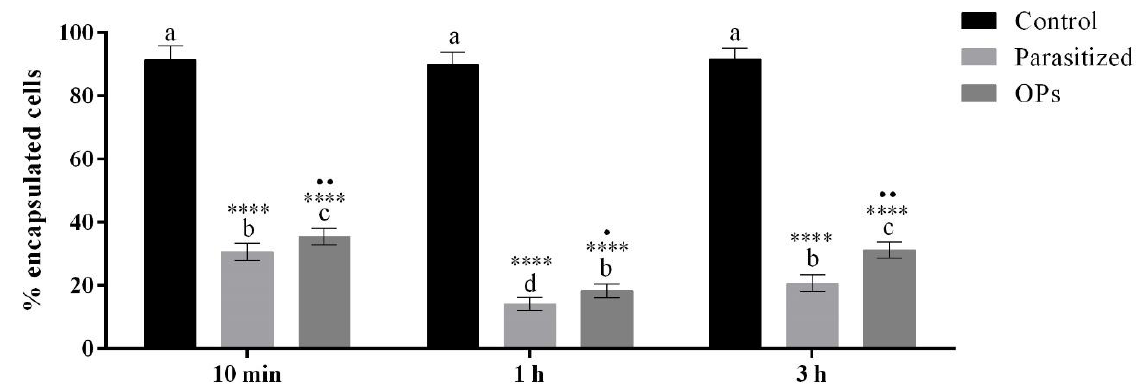
Figure 8. Percentage of encapsulation of chromatographic spheres extracted after 6 h from larvae injected with 1 × PBS (control), after parasitization or OP treatment at 10 min, 1 h or 3 h before injection of spheres. Data are presented as mean ± SD ( n = 3). Statistical analysis was performed with one-way ANOVA and Bonferroni (for control vs. treatment and parasitized vs. OPs analysis) and Tukey post-hoc test (for all sample analysis). Different letters indicate significant differences among all treatments ( p value < 0.0001), asterisks indicate significant differences between control and treated samples at the same experimental time ( p value < 0.0001), dots indicate significant differences between parasitized and OP treatment at the same experimental time (●● p value < 0.01, ● p value < 0.05).